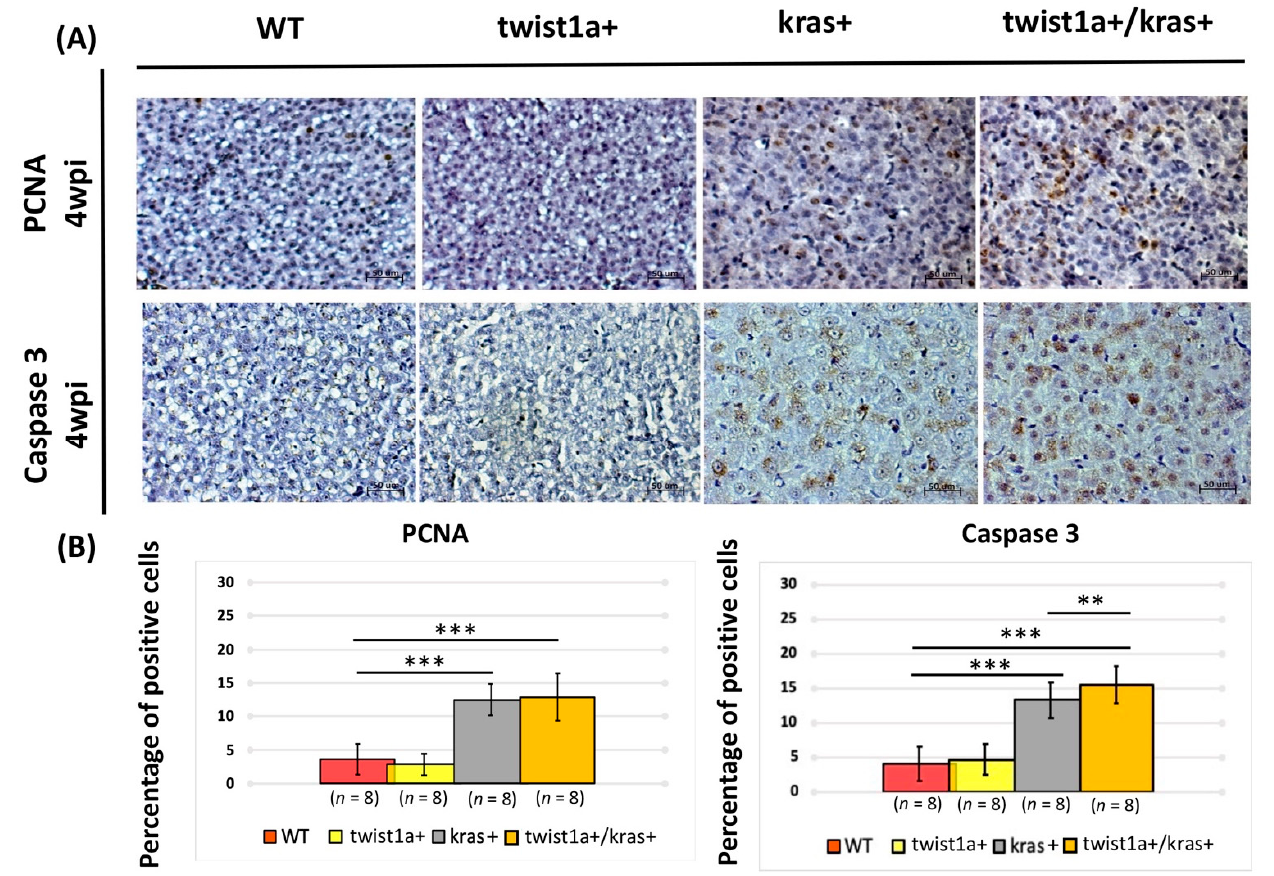
Figure 3. Main hallmarks of cell proliferation and cell apoptosis in liver tissues from twist1a+/kras+ double transgenic zebrafish. ( A ) Immunohistochemical staining micrograph showing proliferating and apoptotic cells in liver cross-sections from wild-type, twist1a +, kras +, and twist1a+/kras zebrafish. ( B ) Quantification of the percentage of positive cells for the all fields following PCNA and caspase-3 staining at 4 wpi using ImageJ. Scale bar: 50 μ m. Student’s t -tests were used to assess differences between variables: ** p < 0.01, *** p <